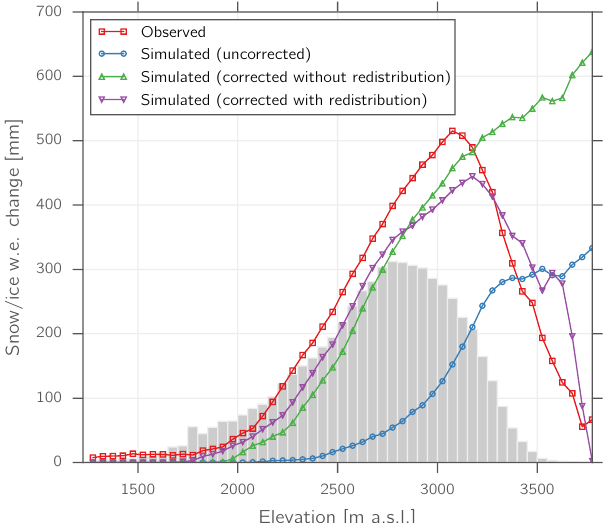
Figure 12. Observed vs. simulated water equivalent differences for the winter 2010/2011 (8 October to 22 April) by elevation (50m bands). Simulation results are displayed for using uncorrected pre- cipitation (elevation-dependent remapping only), corrected precip- itation without topographic redistribution (Eq. (7) plus constant snow correction factor (15%)), and corrected precipitation with to- pographic redistribution (Eq. (10)). The gray bars represent the rel- ative area distribution of the elevation bands.